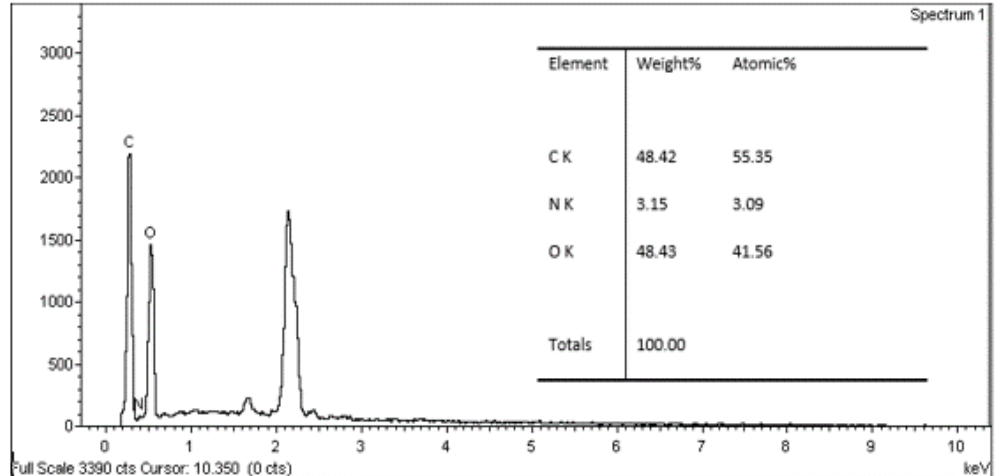
Figure 10. Energy dispersive X-ray spectrum for Rhizophora spp. particleboard bonded with 0% binders.